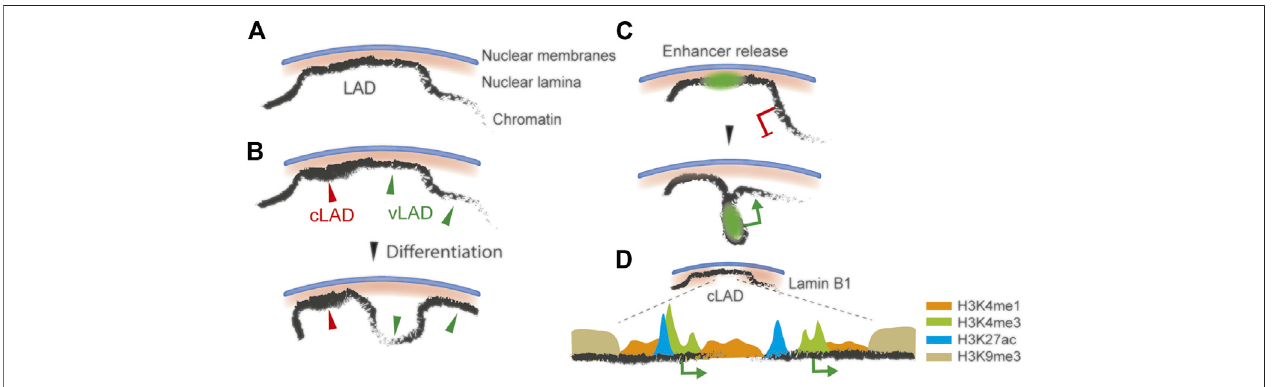
FIGURE 1 | Dynamics and heterogeneity of LADs (A) Interaction of chromatin with the NL via a LAD (B) Variable LADs (vLADs) are repositioned in the genome during differentiation (C) Enhancer (green area) release from the NL by LAD detachment, and activation of a nearby gene (green arrow) (D) Active cLAD sub-domain of lower lamin B1 level than the rest of the LAD, depleted of H3K9me3 but enriched in euchromatic histone modi fi cations (H3K4me1, H3K4me3 and H3K27ac). Genes in these sub-domains escape the heterochromatic repressive environment of